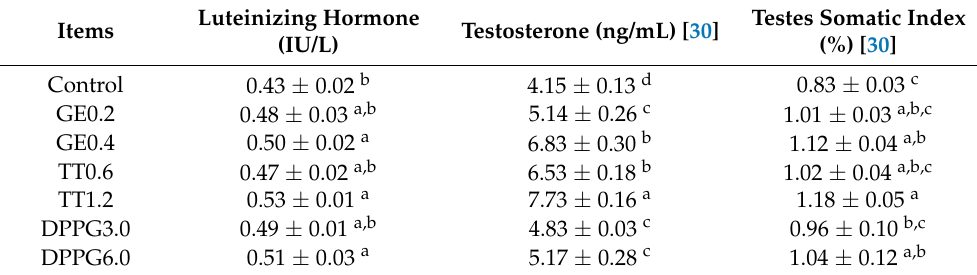
Table 2. Effect of different levels of different antioxidant supplementation (g/kg diet) on luteinizing hormone, testosterone levels, and testis somatic index of Nile tilapia, O. niloticus , fingerlings.